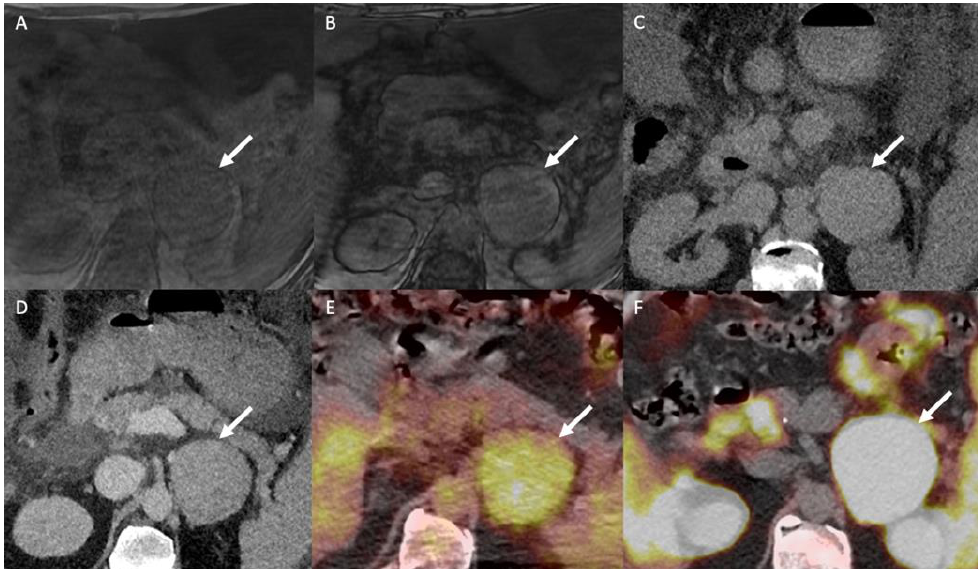
Figure 7. A 60-year-old man with multifocal hepatocellular carcinoma and a left adrenal mass. The T1-weighted in-phase ( A ) and out-of-phase ( B ) images in the axial plane show an enlarged left adrenal gland (arrow) without a signal drop between the in-phase (signal intensity = 243) and out-of-phase (signal intensity = 236) images, consistent with absent intracellular fat content. ( C ) The unenhanced CT image in the axial plane reveals a 66-mm, well limited and homogeneous left adrenal mass (arrow), with a mean attenuation value of 31 Hounsfield units (HU). ( D ) The contrast-enhanced CT images obtained at 60 s after intravenous administration of iodinated contrast material in the axial plane show a homogeneously enhanced adrenal mass with a mean attenuation value of 55 HU. The mean attenuation values were 48 HU at 60 s, 40 HU at 5 min and 38 HU at 10 min. The absolute washout percentage was 59% and the relative washout percentage was 21%. These findings are not typical of a benign adrenal mass and are consistent with a malignant adrenal lesion. ( E ) The 18 F-FDG PET/CT image in the axial plane shows increased uptake of 18 F-FDG by the left adrenal mass (arrow), with a SUVmax of 5.2. The SUVmax of hepatic parenchyma was 4.8, resulting in a liver to adrenal ratio of 1.1. ( F ) The 18 F-choline PET/CT image in the axial plane shows an increased uptake of 18 F-FDG by the left adrenal gland with a SUVmax of 14.8. 18 F-choline is a radio tracer that shows high uptake by hepatocellular carcinoma. The discordance between the low 18 F-FDG uptake and the marked 18 F-choline uptake is common for poorly differentiated hepatocellular carcinoma metastases. Histopathological analysis of the tissue sample obtained by percutaneous biopsy confirmed adrenal metastasis from hepatocellular carcinoma.